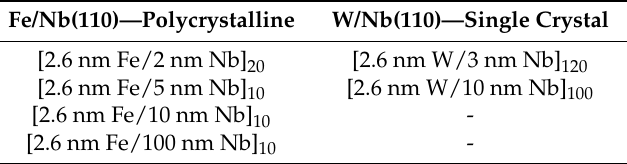
Table 1. List of samples for the Fe/Nb and W/Nb measurements. The description in the brackets is the thickness of each layer in a single bilayer. The number in subscript represents how many times each bilayer was repeated.